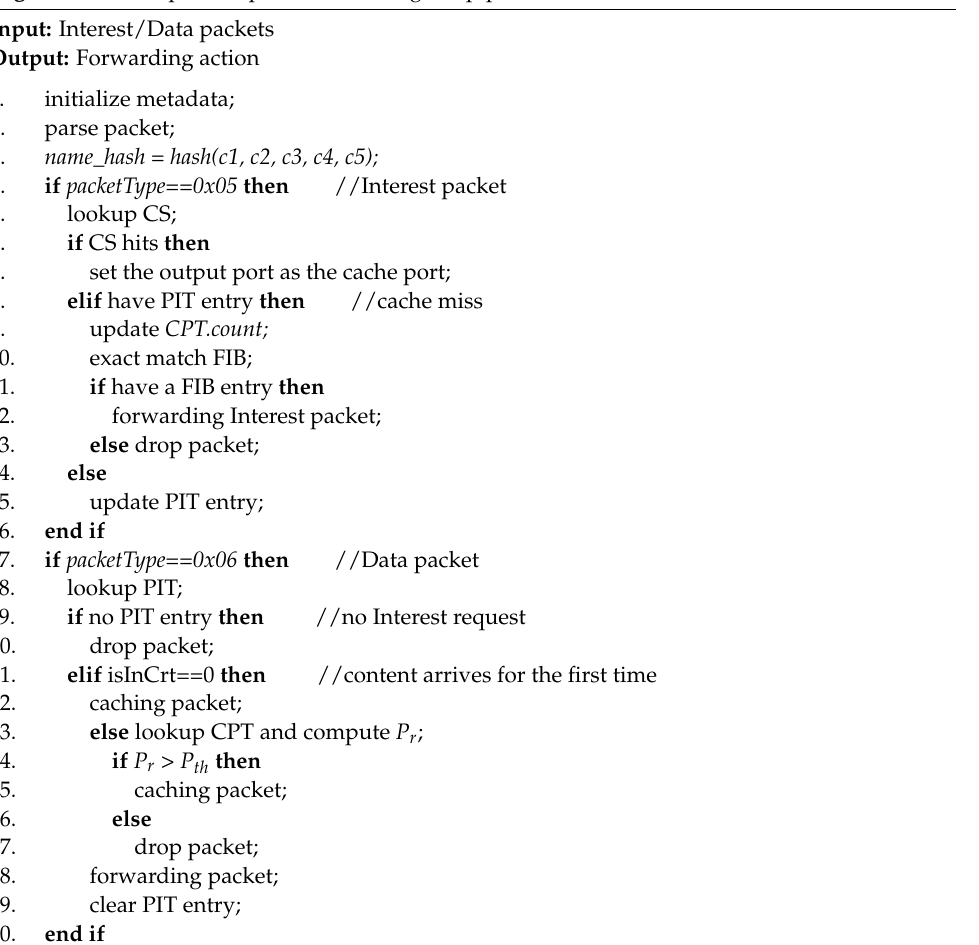
Algorithm 1. The packets process of the ingress